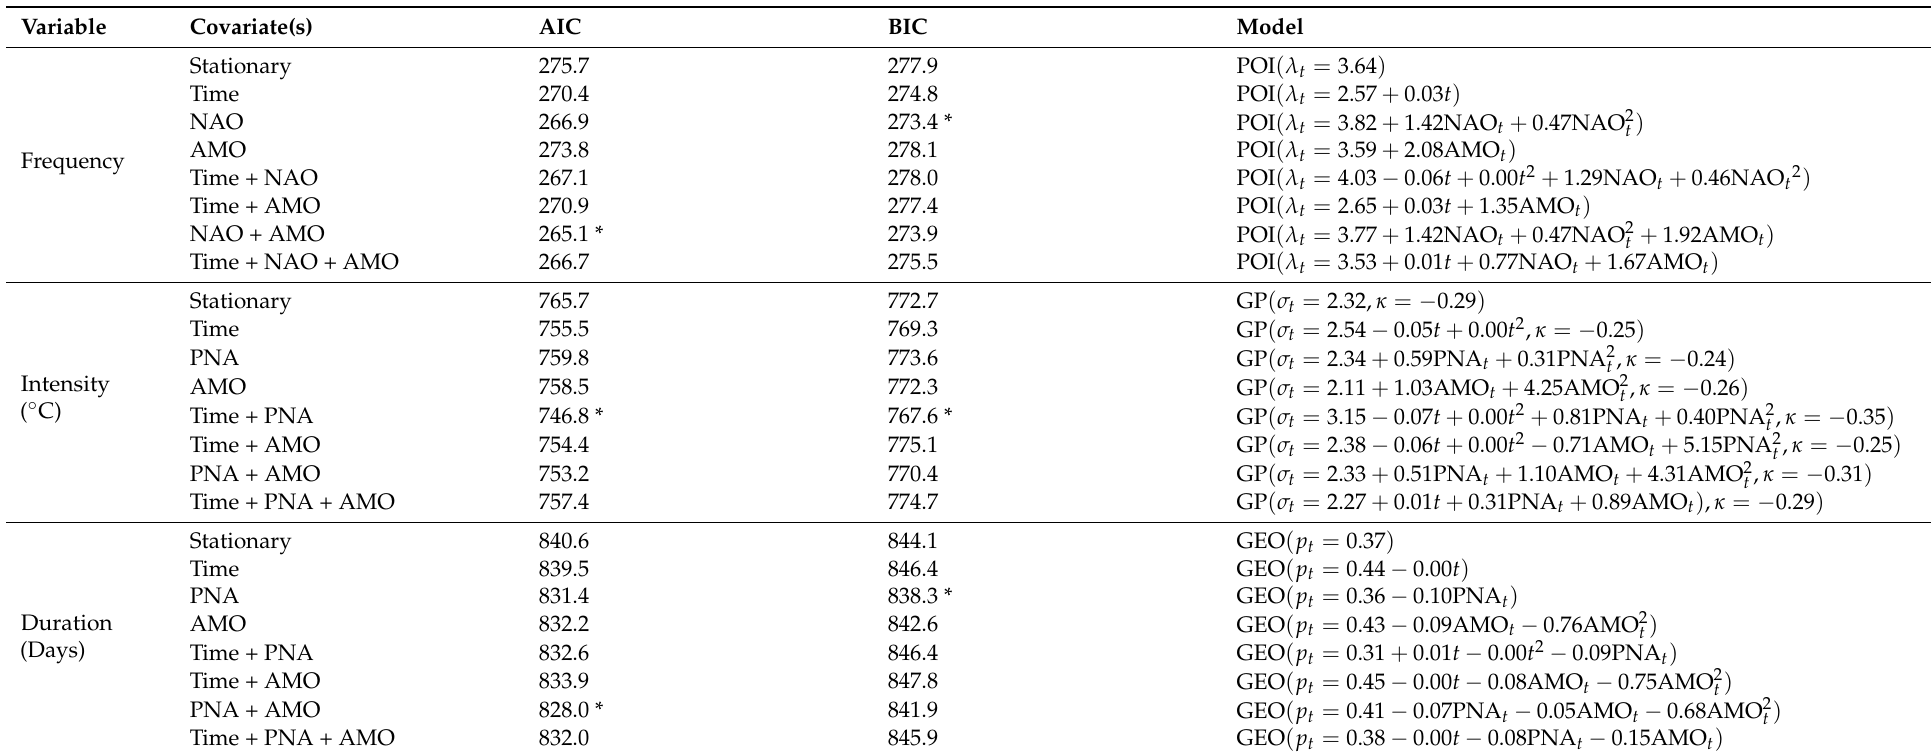
Table 2. The Dijon station corresponds to stationary/non-stationary models for each heat spell variable. AIC and BIC statistics for the optimal model of each configuration of covariates. For non-stationary models, different combinations of covariates were considered. In each case, the optimal non-stationary model based on the AIC statistic is